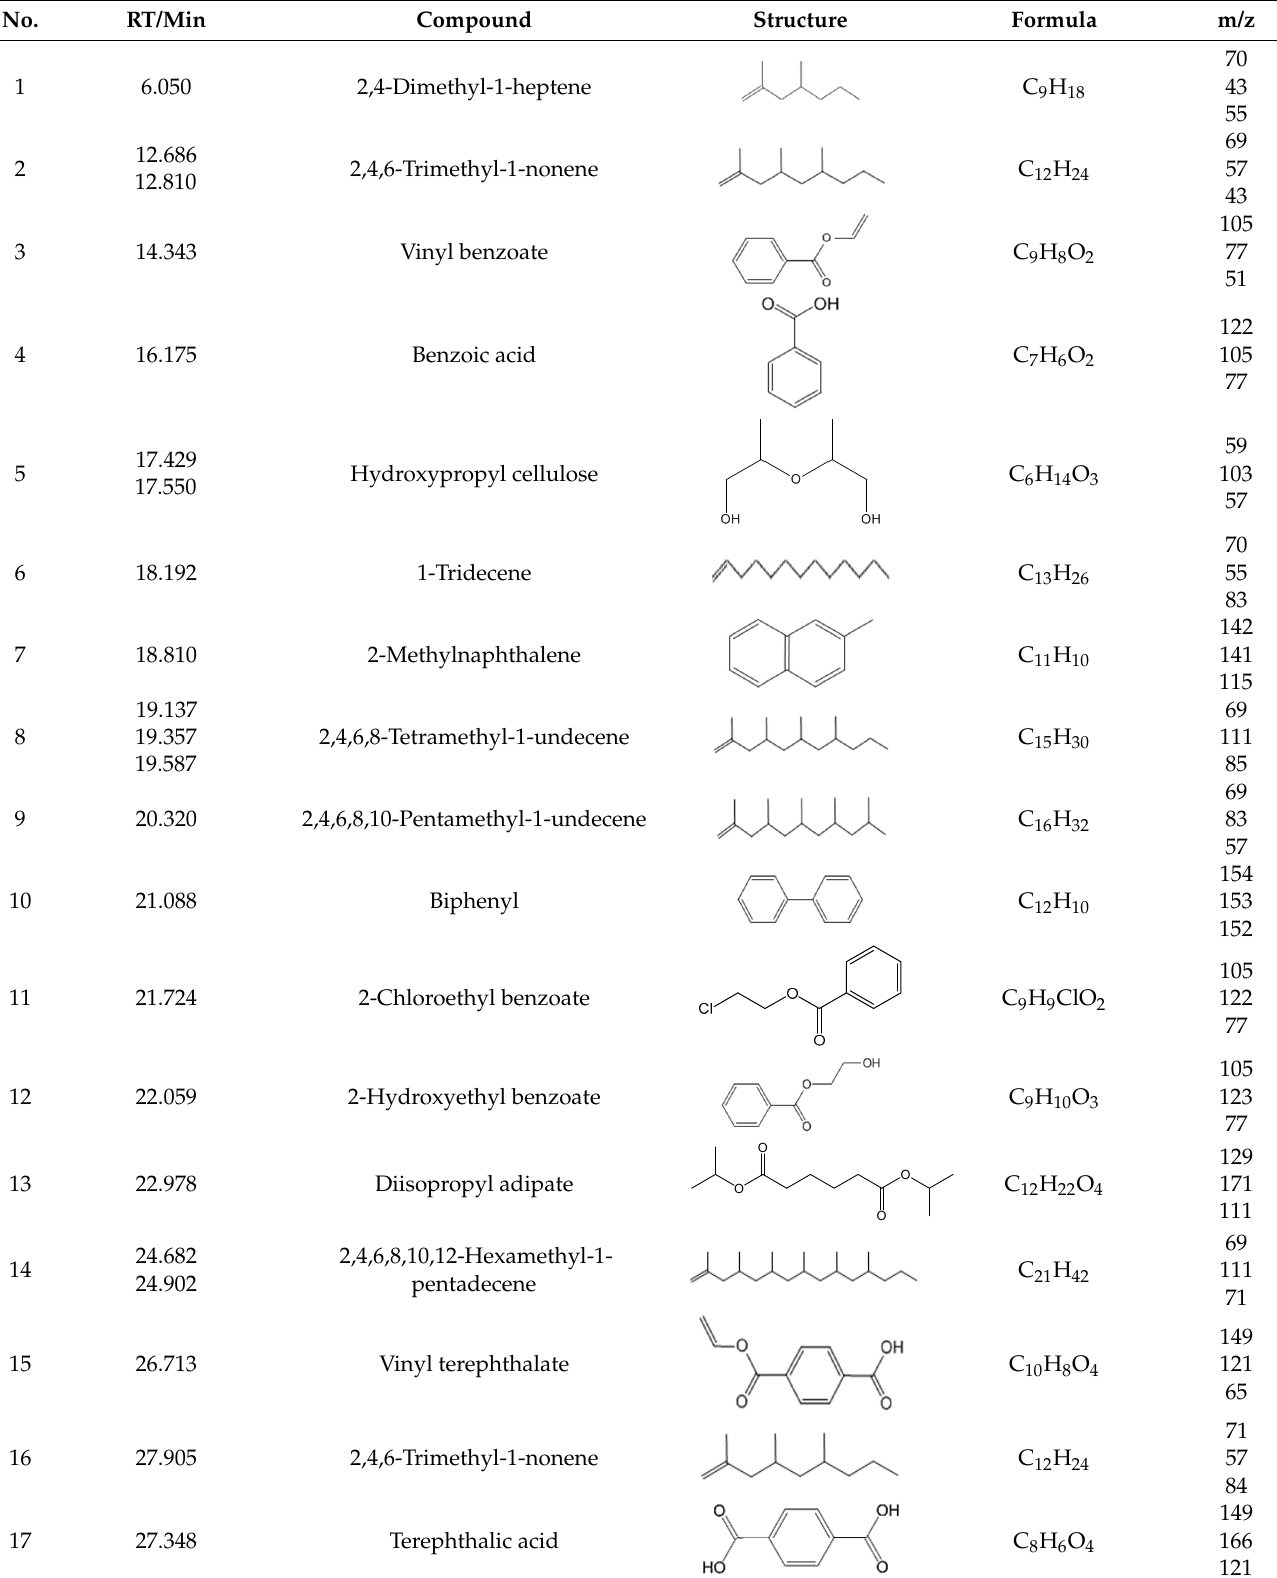
Figure 3. TED-GC-MS chromatogram of MP. The color of the number indicates the origin: red: PP, blue: PET, green: PVC, black: compounds newly appearing in MP. Table 1. Thermal-degradation compounds of MP shown in Figure 3.